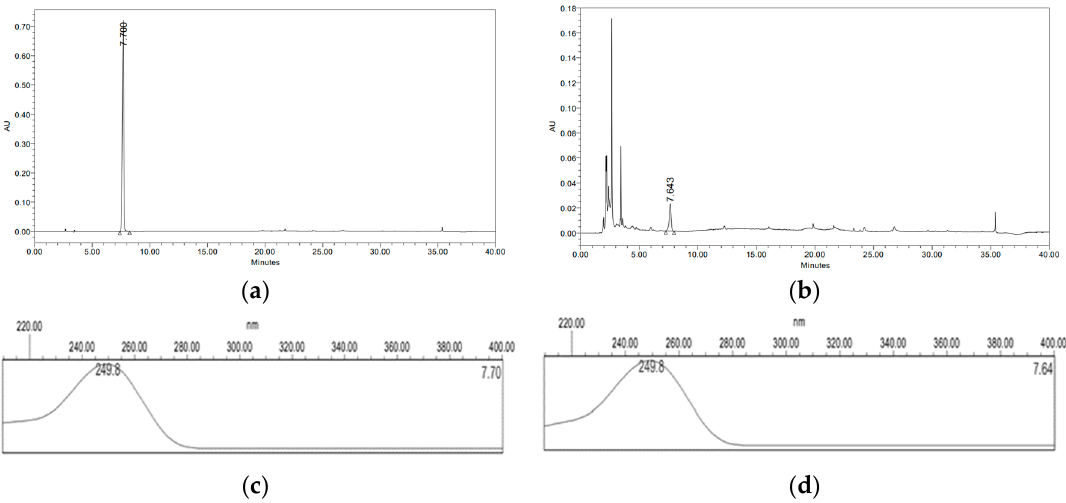
Figure 1. HPLC chromatograms of 2-furoic acid ( a ) and HR1901-W ( b ). PDA spectra of 2-furoic acid ( c ) and HR1901-W ( d ) from the chromatogram.